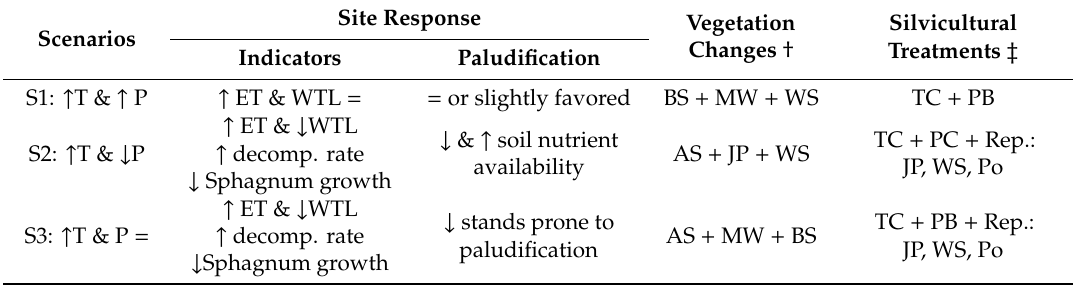
Table 2. Response of paludification to predicted climate change under three di ff erent scenarios (S1–S3) in the Clay Belt region, expected vegetation changes, and proposed silvicultural